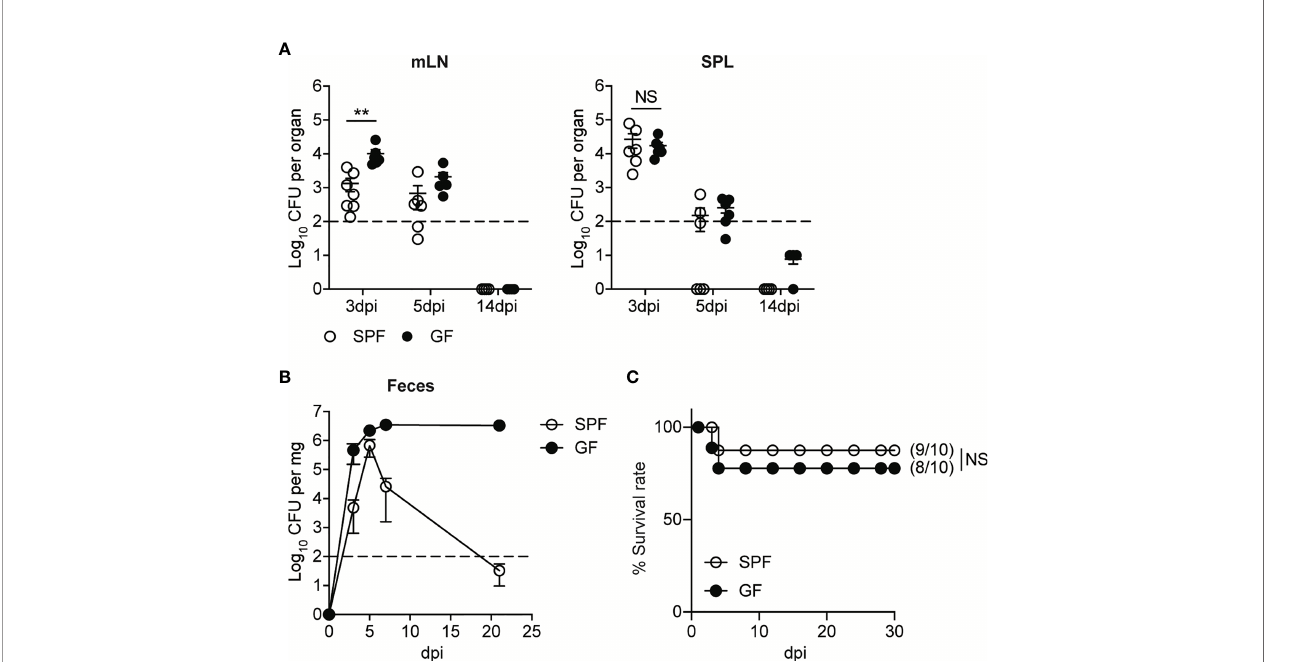
FIGURE 1 | GF mice Effectively Resolve Oral Infection of L. monocytogenes Despite its Persistent Presence in the Lumen. SPF and GF mice were orally infected with 5 x 10 8 CFU of InlA m LM-OVA. (A) L. monocytogenes counts were determined as colony forming unit (CFU) in mesenteric lymph nodes (mLN) and spleen (SPL) of SPF and GF mice at indicated time points. Data point represents an individual mouse. Data are pooled from two independent experiments (n=6 at 3 and 5 dpi, n=4 at 14 dpi). (B) L. monocytogenes counts in feces were determined at the indicated time points. Data are representative of at least three independent experiments (n=4 per group). Statistical differences were determined by two-way ANOVA with Tukey ’ s multiple comparisons. (C) Survival rate at the indicated time points after oral infection of InlA m LM-OVA . Numbers in parentheses indicate the ratio of surviving mice to total mice. The log-rank test was used to determine statistical differences in survival curves. Data are pooled from two independent experiments (n=10 per group). **P < 0.01; NS, not statistically signi fi